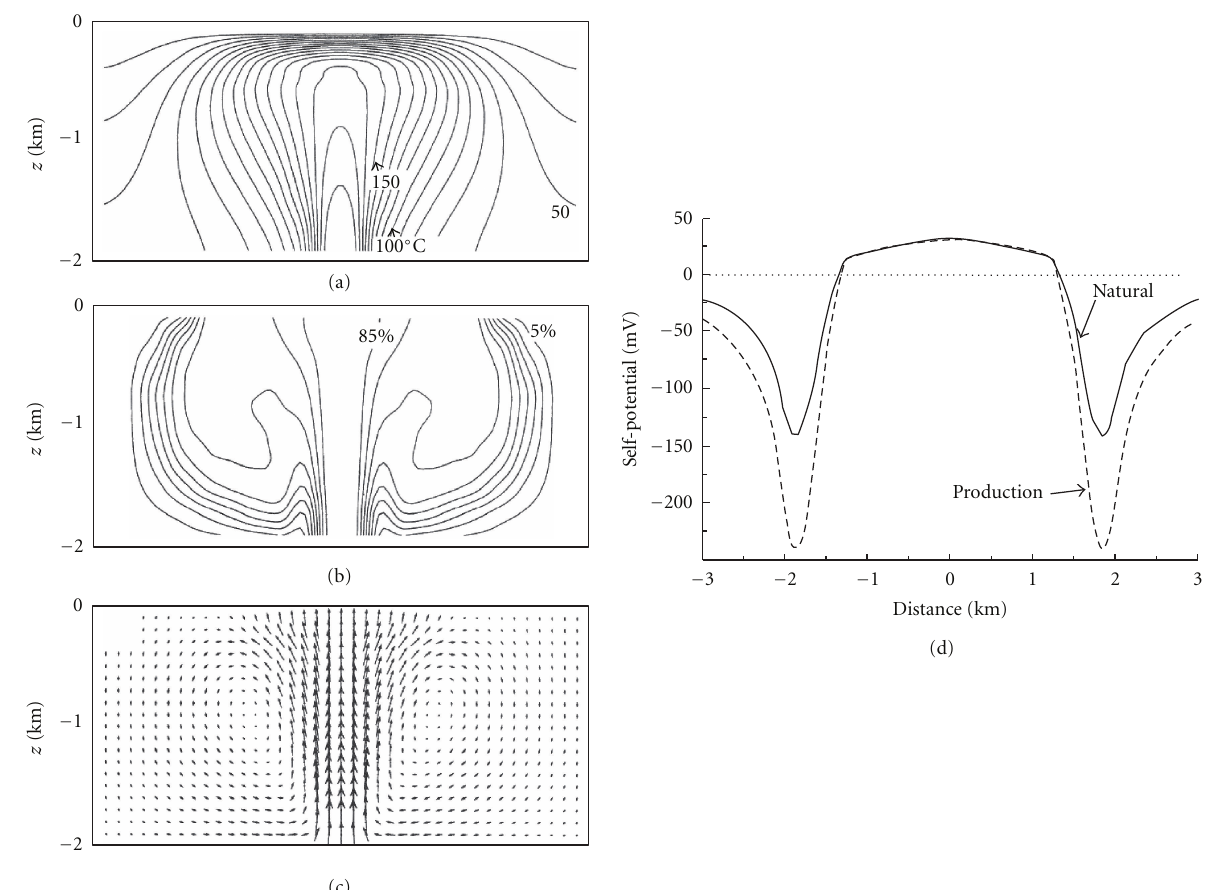
Figure 5: Results of reservoir simulation: natural-state distributions of (a) temperature (contour interval 10 ◦ C), (b) mass fraction of “source fluid”, and (c) fluid mass flux. Earth-surface SP distributions computed by the so-called “ EKP postprocessor ” for this natural state (solid curve), and for a subsequent exploited state (broken curve), are shown in (d), after [57].